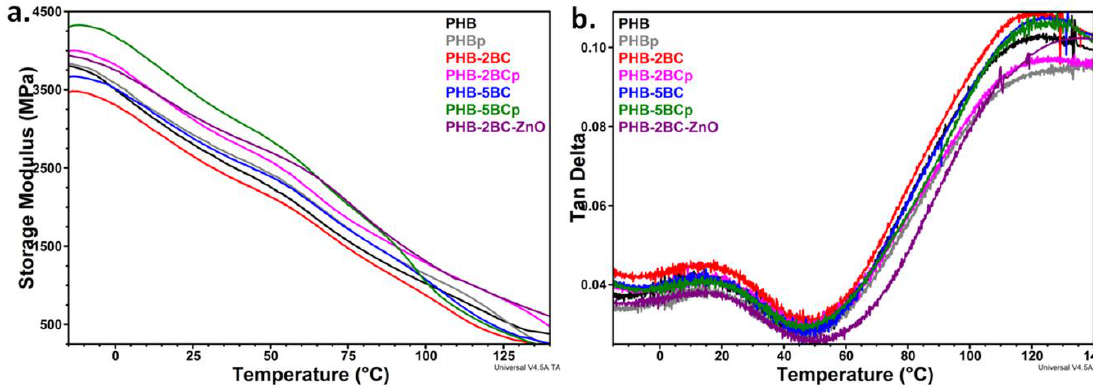
Figure 8. Storage Module ( a ) and tangent of mechanical loss angle (loss factor, tan δ ) ( b ) of PHB nanocomposites with 2 and 5 wt % BC before (-) and after plasma treatment (p). Table 3. DMA results: glass transition of PHB ( T g ), T α * transition (crystal-crystal slip) and storage modulus ( E’ ) values at different